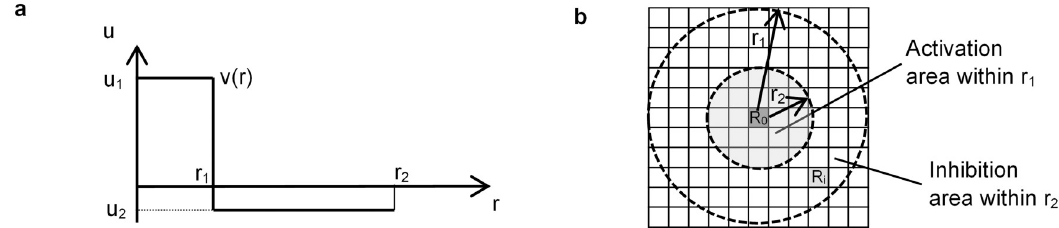
Fig 2. Outline of Young’s model. (a) Function v(r) is a continuous step function representing the activation area and inhibition area. (b) The activation area has a radius r 1 , and the inhibition area has an outer radius r 2